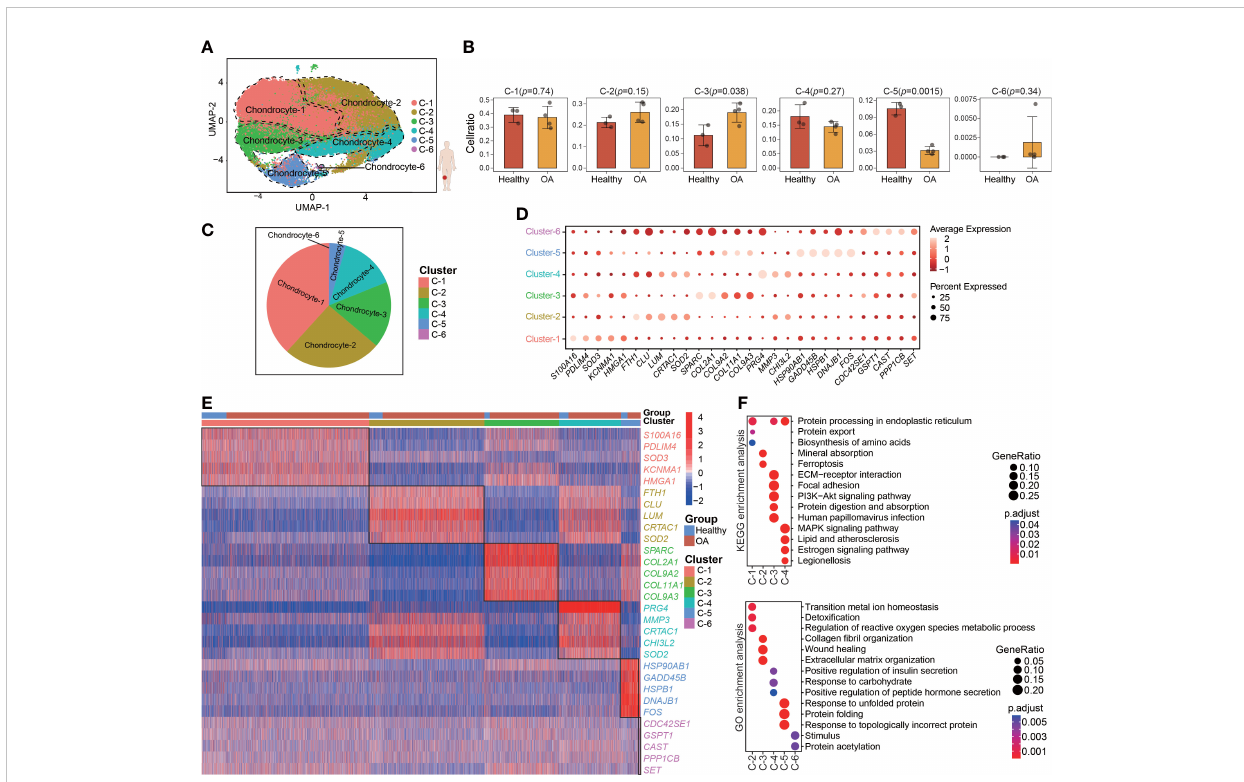
FIGURE 1 Single-cell Transcriptome pro fi ling and clustering of human cartilage chondrocytes. (A) Visualization of umap colored according to cell clusters for 62449 chondrocytes from human OA cartilage single-cell transcriptomes. (B) Bar plots showing the comparison of different cell clusters between normal and OA samples. (C) Pie chart showing the distribution of different cell clusters. (D) Dot plot showing the expression of selected markers (top 5 marker genes, ranked by ‘‘ logFC ’’ ) of various cell clusters. (E) Heatmap of the scaled expression of top 5 marker genes for each cluster. (F) Dot plot showing the signi fi cant signaling pathways and biological processes identi fi ed by GO and KEGG enrichment analysis. All data are expressed as the mean ± SD. Student ’ s t test was used for statistical analysis. p < 0.05 was considered statistically signi fi